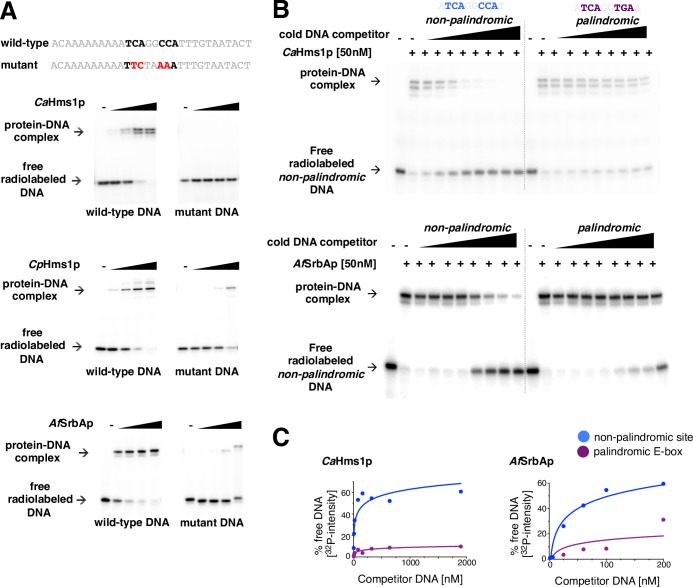
Several fungal SREBPs exhibit an intrinsic DNA binding preference for a non-palindromic DNA motif.(A) Gel shift assays showing binding of three fungal SREBPs to a non-palindromic DNA sequence. P32-labeled DNA fragments containing the wild-type or mutant non-palindromic binding site were incubated with increasing concentrations (0, 1.56, 6.25, 25 and 100 nM) of the purified DNA binding domain of C. albicans Hms1p (top), C. parapsilosis Hms1p (middle) or A. fumigatus SrbAp (bottom) for 90 min at room temperature in standard EMSA buffer and resolved in 6% polyacrylamide gels run with 0.5× TGE. Point mutations introduced in the DNA binding site are shown in red. (B) Competition experiments to determine the DNA binding preferences of the SREBPs CaHms1p (top) and AfSrbAp (bottom). The purified DNA binding domain of either protein was incubated with a P32-labeled DNA fragment containing the non-palindromic binding site. Upon binding, increasing concentrations of unlabeled competitor DNA fragments harboring either palindromic E-box or non-palindromic binding sites were added to the reactions, and the mixtures were then resolved by polyacrylamide gel electrophoresis. (C) Quantification of competition assays shown in B. Plotted is the amount of radiolabeled DNA that becomes protein-free upon addition of unlabeled DNA competitor. Notice that the rapid increase in signal in the blue curve indicates that both proteins show strong preference (at least one order of magnitude) for the non-palindromic DNA sequence.